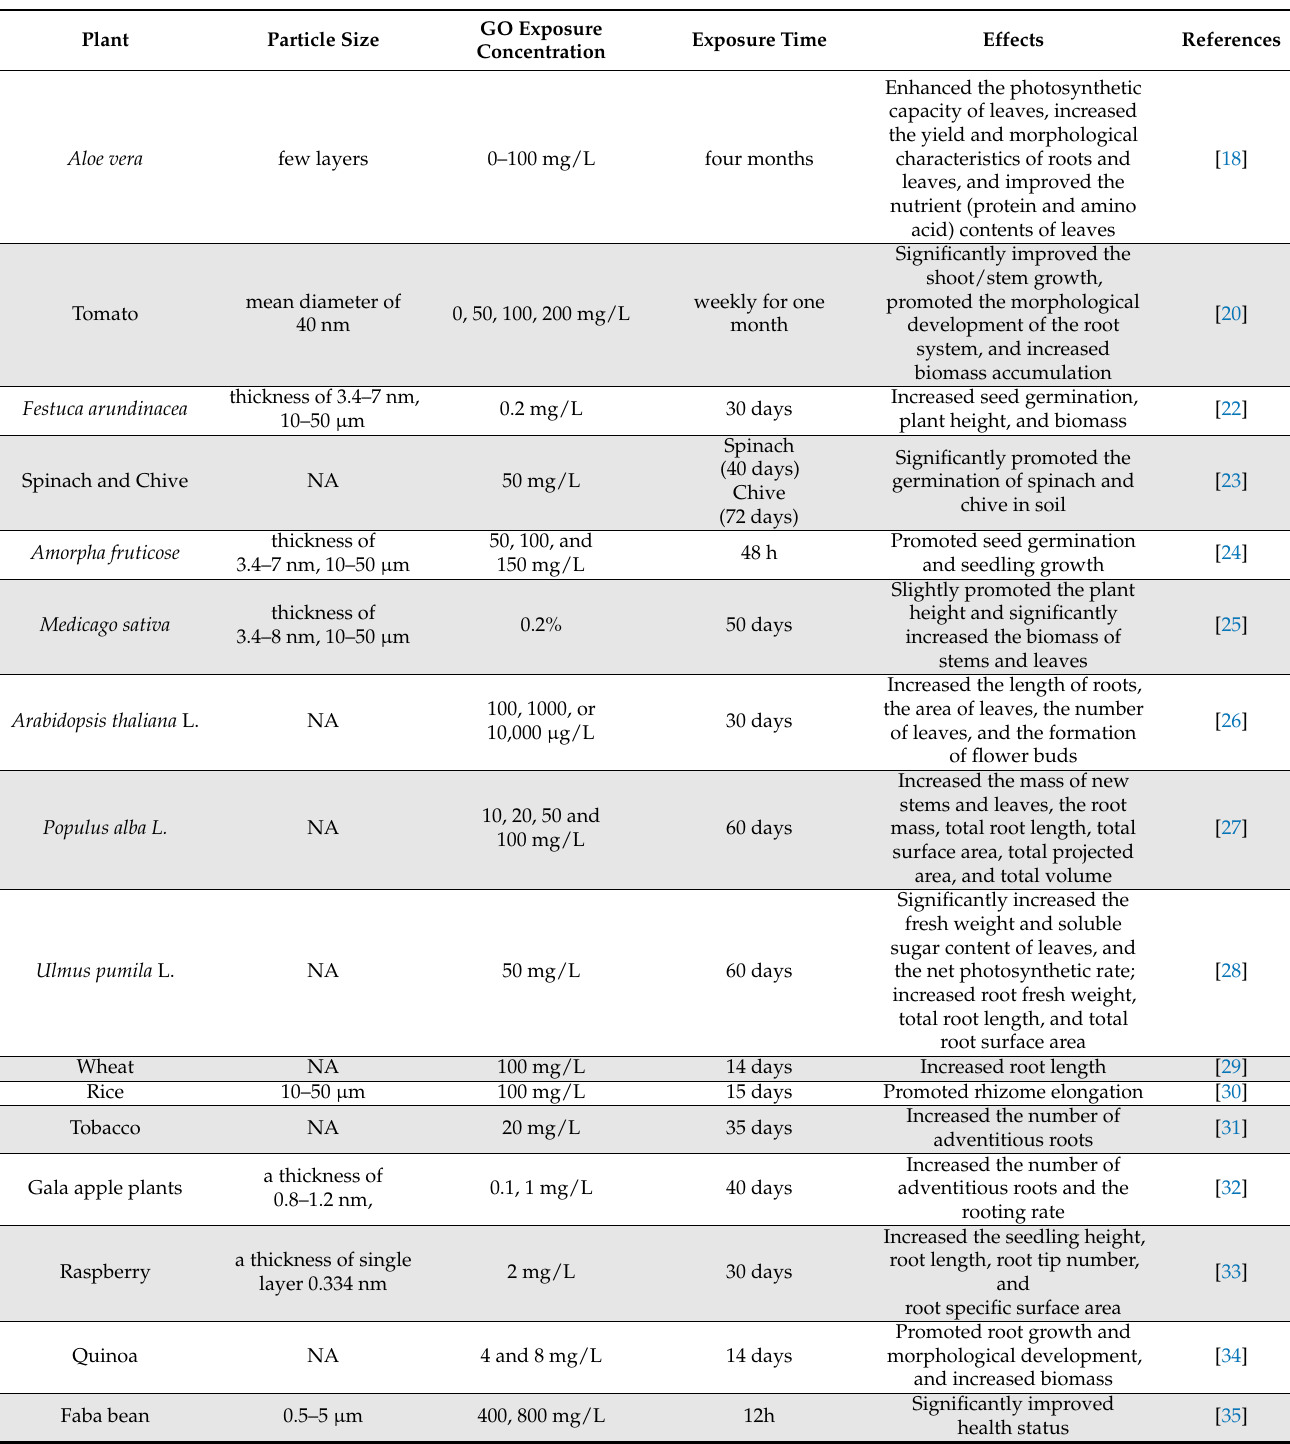
Table 1. Beneficial effects of GO on plant